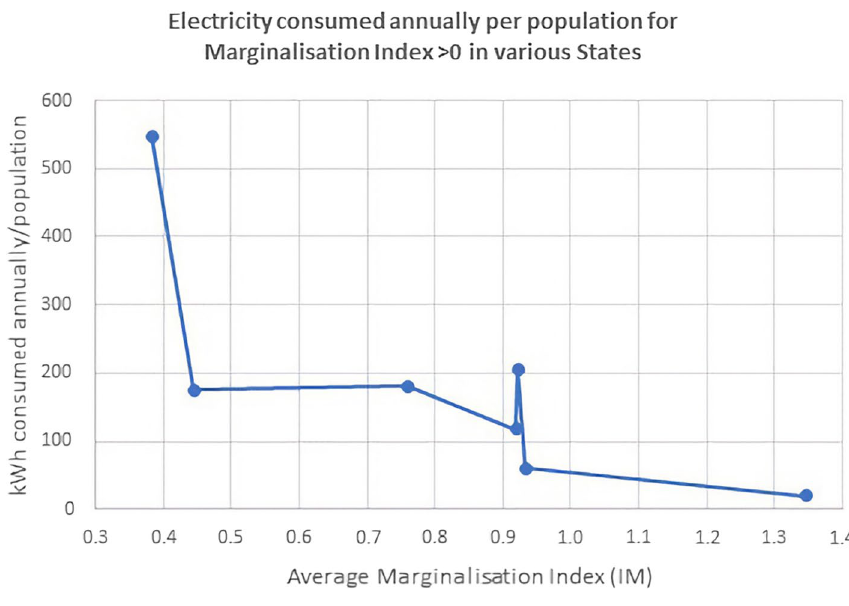
Equipment Electricity pro- kWh consumed/ IM Electricity consumed duced (MWh/year) Population potential/ con-